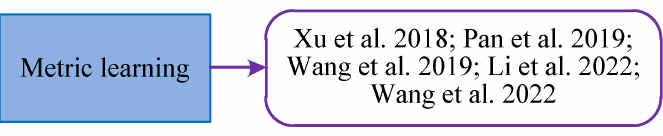
Figure 18. Metric learning used in SAR ATR [142–146].